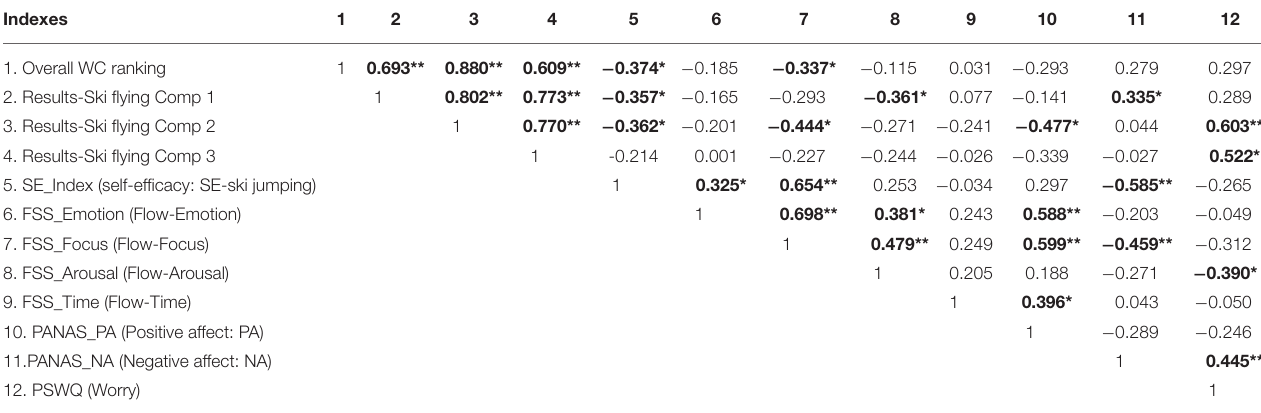
TABLE 3 | Correlations (Pearson) between the ski jumping results and scores from the psychological factors (WC ski jumpers, valid n = 39).